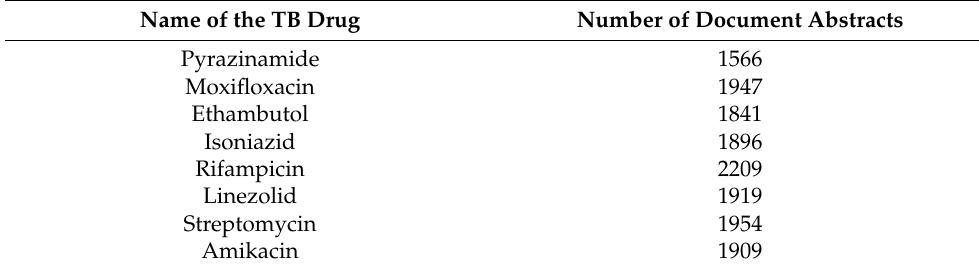
Table 1. Number of documents collected from PubMed for each drug.